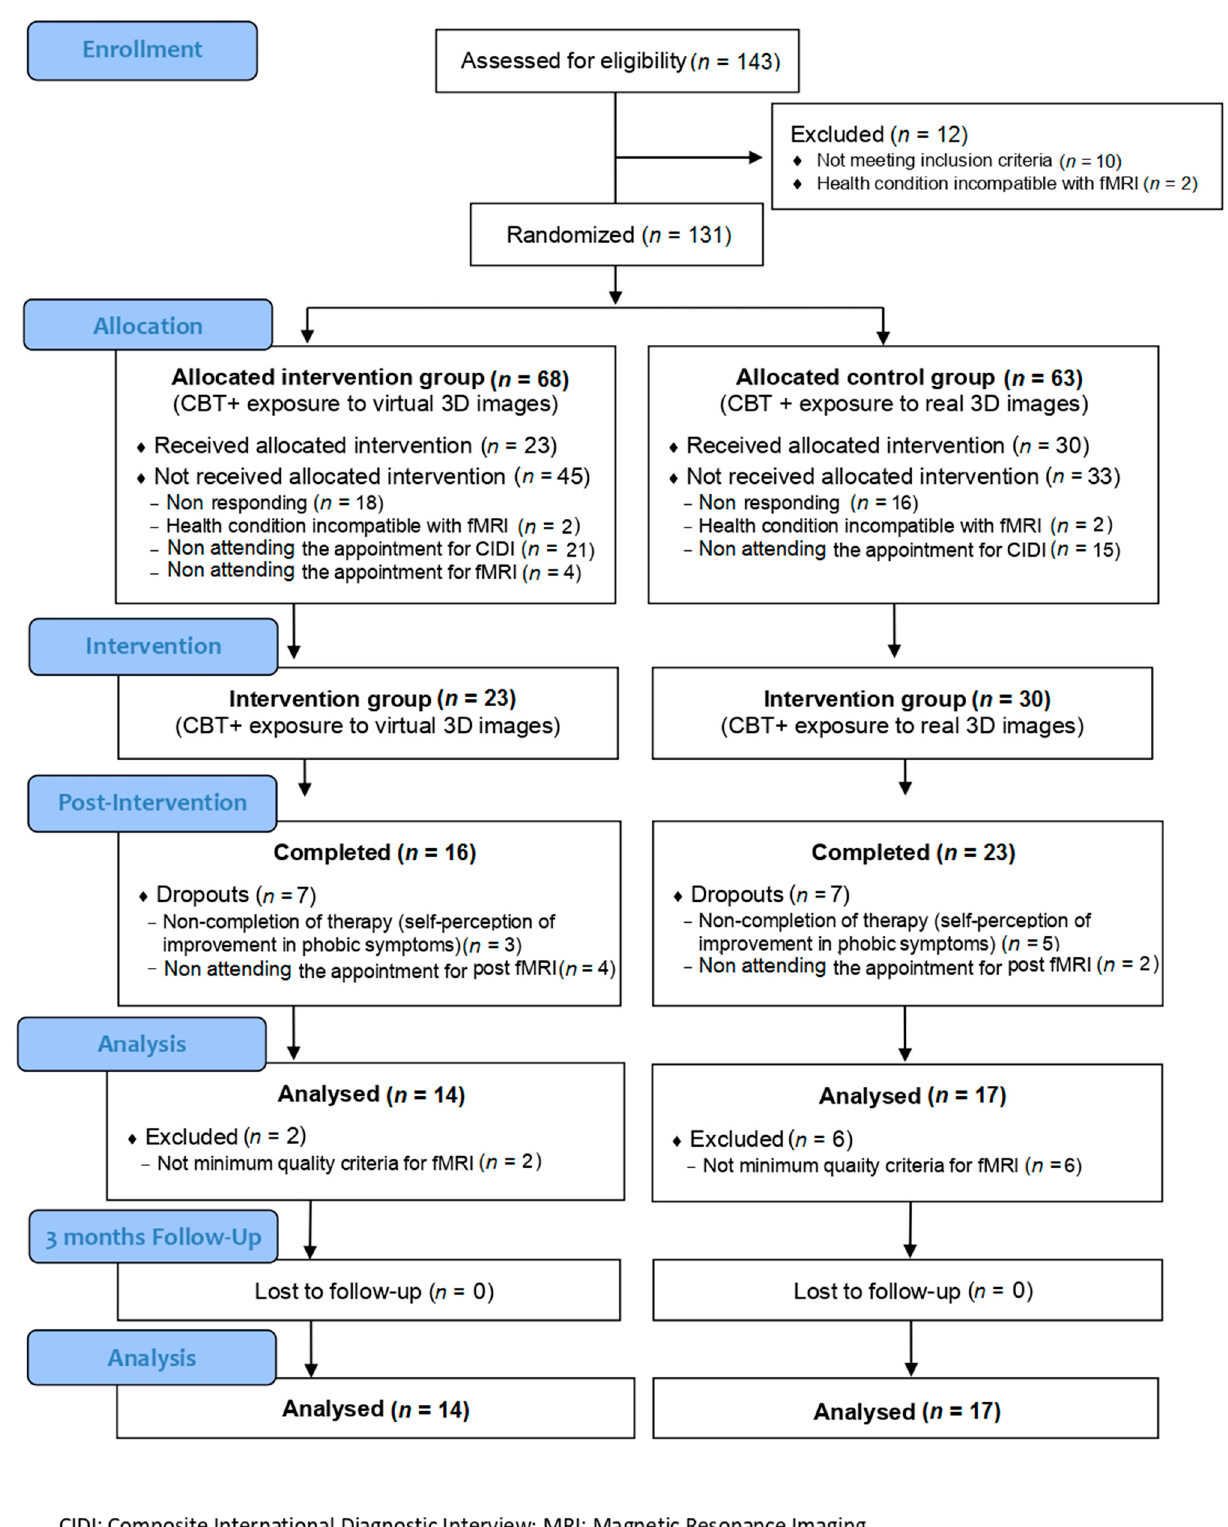
Figure 1. Flow diagram of study enrollment.